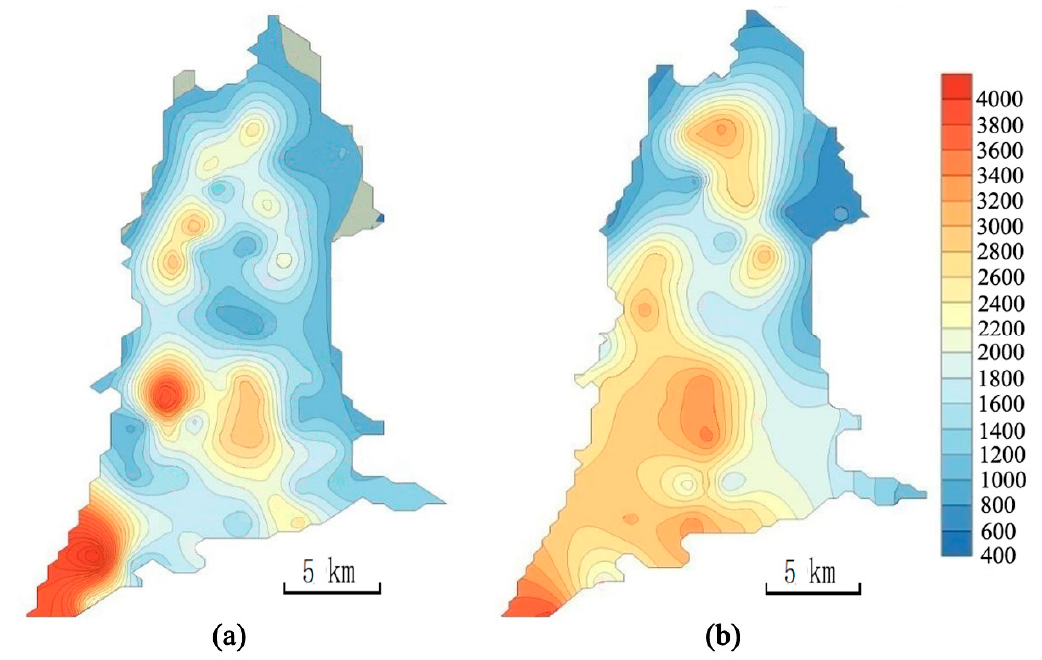
Figure 4. Contour map of groundwater TDS in different seasons: ( a ) spring in 2018 and ( b ) autumn in 2018.